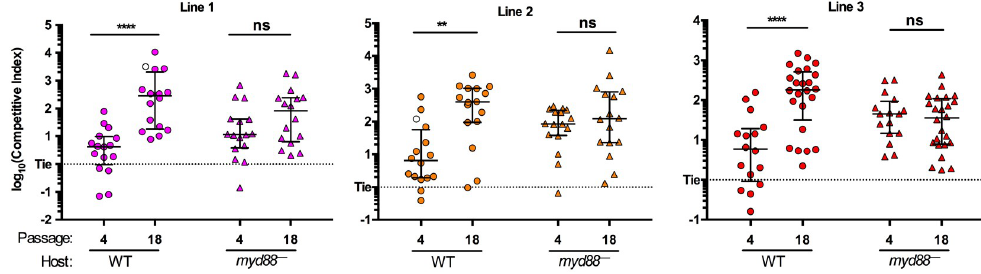
Fig 6. Further-evolved isolates have host genotype–dependent competitive fitness outcomes. CIs of evolved isolates and the ancestor, when competed against a differentially tagged ancestral strain in either WT (circles) or myd88 — (triangles) larval zebrafish. Each data point represents a CI from an individual fish. Open symbols represent data points at which the reference strain was undetected on plates; therefore, CIs were calculated by setting the abundance of the reference strain to the limit of detection (5 CFU/gut), thus providing a lower bound for the CI for these points. ���� p < .0001, �� p < .01, � p < .05, ANOVA, log-transformed data, Tukey post hoc analysis. Data combined from two independent experiments for all assays ( n � 16/condition). Underlying data are provided in S1 Data. CFU/gut, colony-forming unit per gut; CI, competitive index; ns, not significant; WT, wild